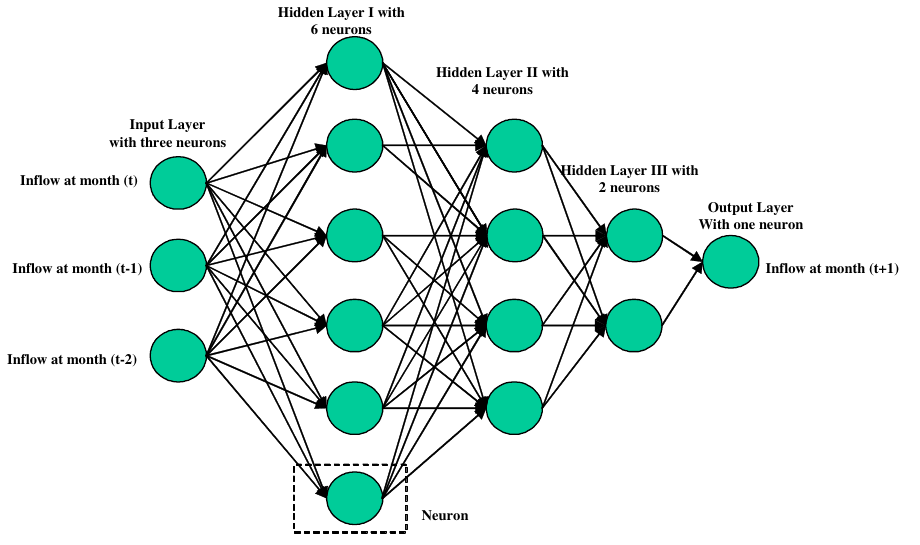
Table 1. The ANN architecture for each month.